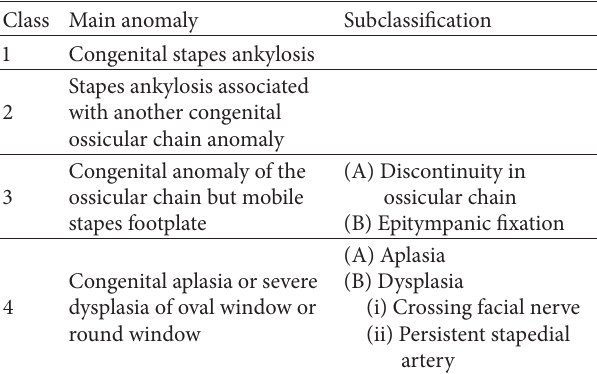
Table 1: Classification of congenital anomalies of the middle ear. Adapted from Teunissen and Cremers